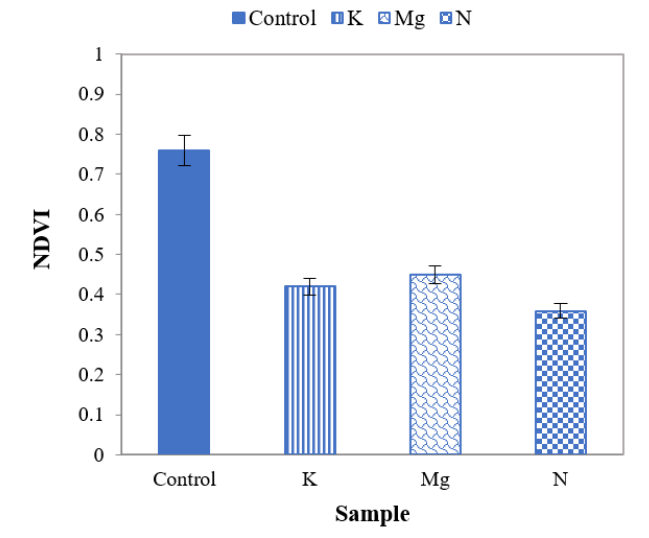
Figure 11. A plot of NDVI for control and different nutrient-deficient leaves to distinguish control and different nutrient-deficient leaves.